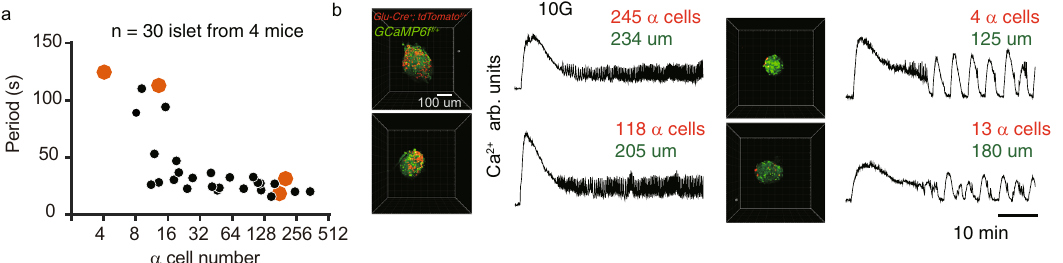
Fig. 6 Islet oscillation frequency depends on the number of α cells. a Scatter plot of islet ’ s α cell number (tdTomato positive cell number) and mean islet Ca 2 + oscillation period under 10 G stimulation ( n = 30 islets from 4 Glu-Cre + ; tdTomato f/ + ; GCaMP6f + mice in 3 independent isolations). The islets labeled with yellow edge dots were shown in b . b 3D image of the islets labeled in a . First and third columns: The tdTomato was expressed in α cells (red) and GCaMP6f in whole islet cells (green). Second and fourth columns: Mean Ca 2 + signal with 40 min 10 G stimulation. The number of α cells (tdTomato positive cells) and the diameter of the islet